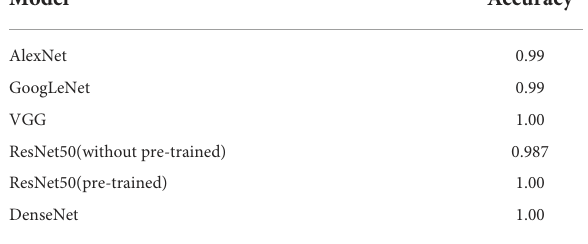
TABLE 1 Classification results for ACI and normal MRI